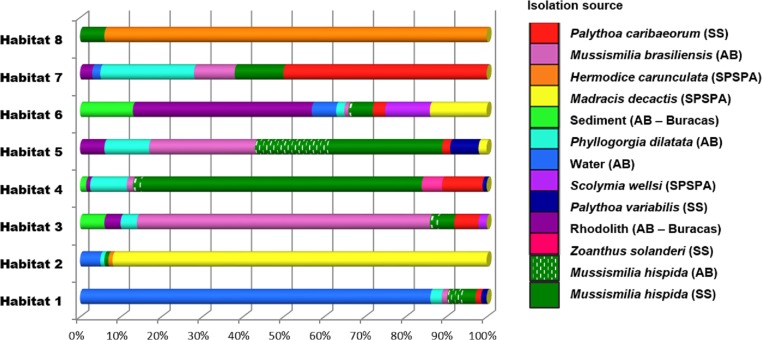
Distribution of the environmental categories that compose each of the 8 habitats predicted by AdaptML.Distributions are normalized by the total number of isolates in each environmental category to reduce the effect of uneven sampling.